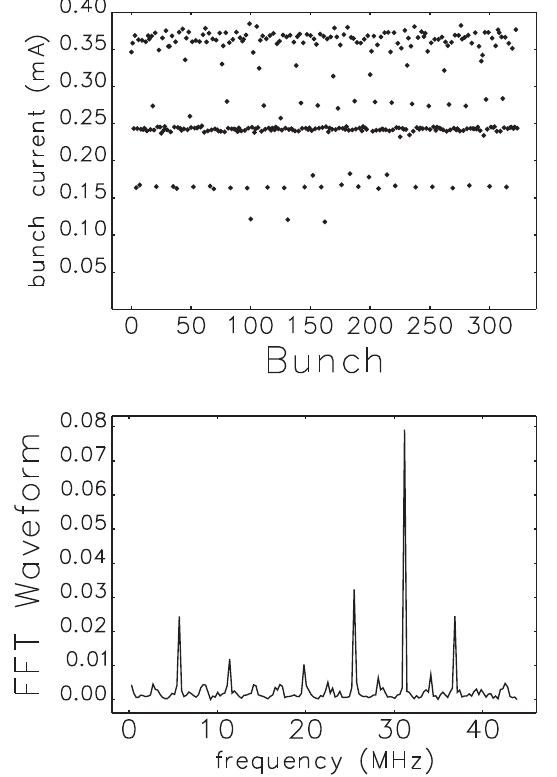
FIG. 10. Top: measured bunch pattern corresponding to Fig. 9. Bottom: FFT of this